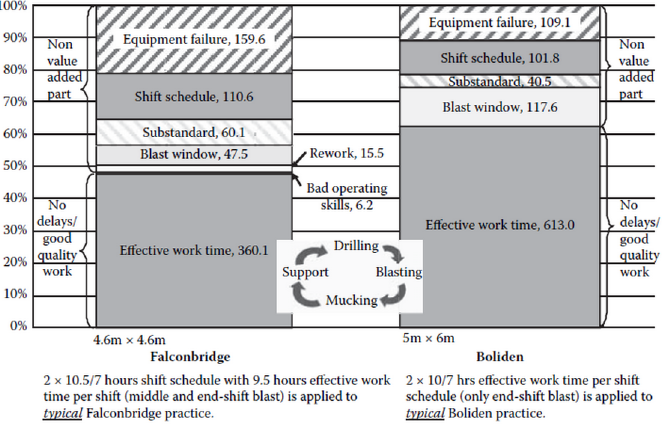
Fig 1. Time delay impacts for typical development practices (with working time in hour) with drilling and blasting